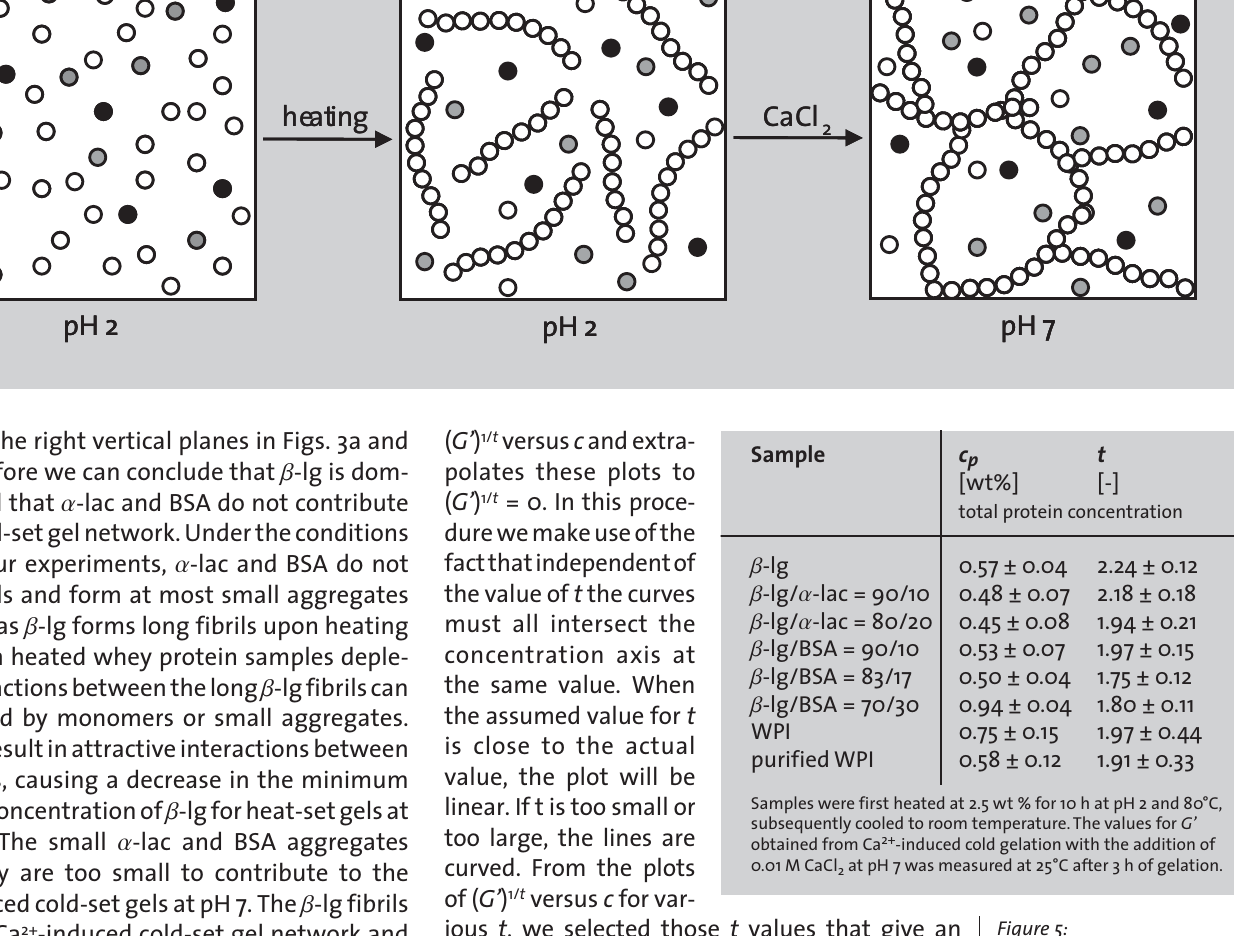
Figure 5: Schematic representation of the Ca 2+ -induced cold-set gelation method for a mix- ture of whey proteins; ( Á ) b - lg; ( Ê ) a -lac; ( Ê ) BSA. First we have whey proteins in solution at pH 2. This solu- tion is heated at a tempera- ture above the denaturation temperature of the protein, and at a total protein con- centration below the heat- induced gelation concentra- tion. Under the conditions used b -lg fibrils are formed during heating. The fibril solution is cooled and the pH is adjusted from pH 2 to pH 7. Gelation is induced by addition of CaCl . 2 Table 2: Calculated values for c and p t for the total whey protein